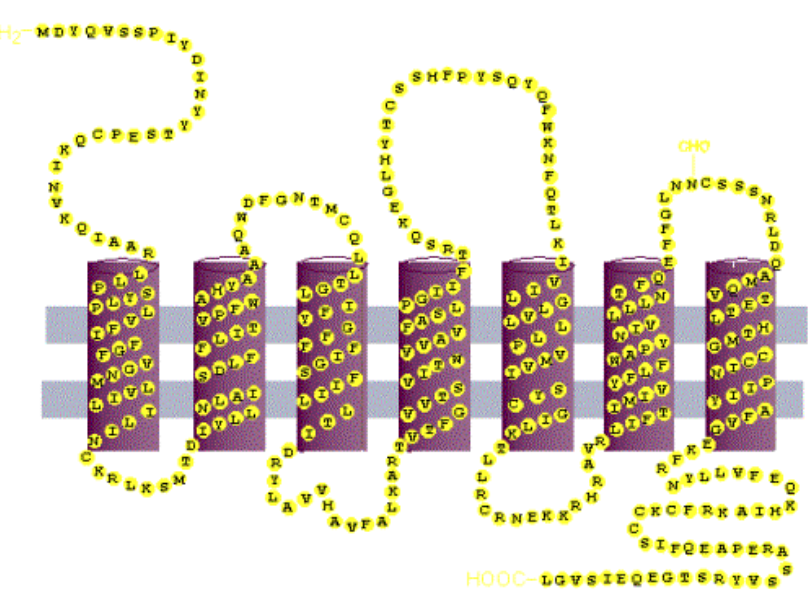
FIGURE 2. Proposed membrane topography of the human CCR5 receptor. Membrane spanning alpha helices are defined based on hydropathy